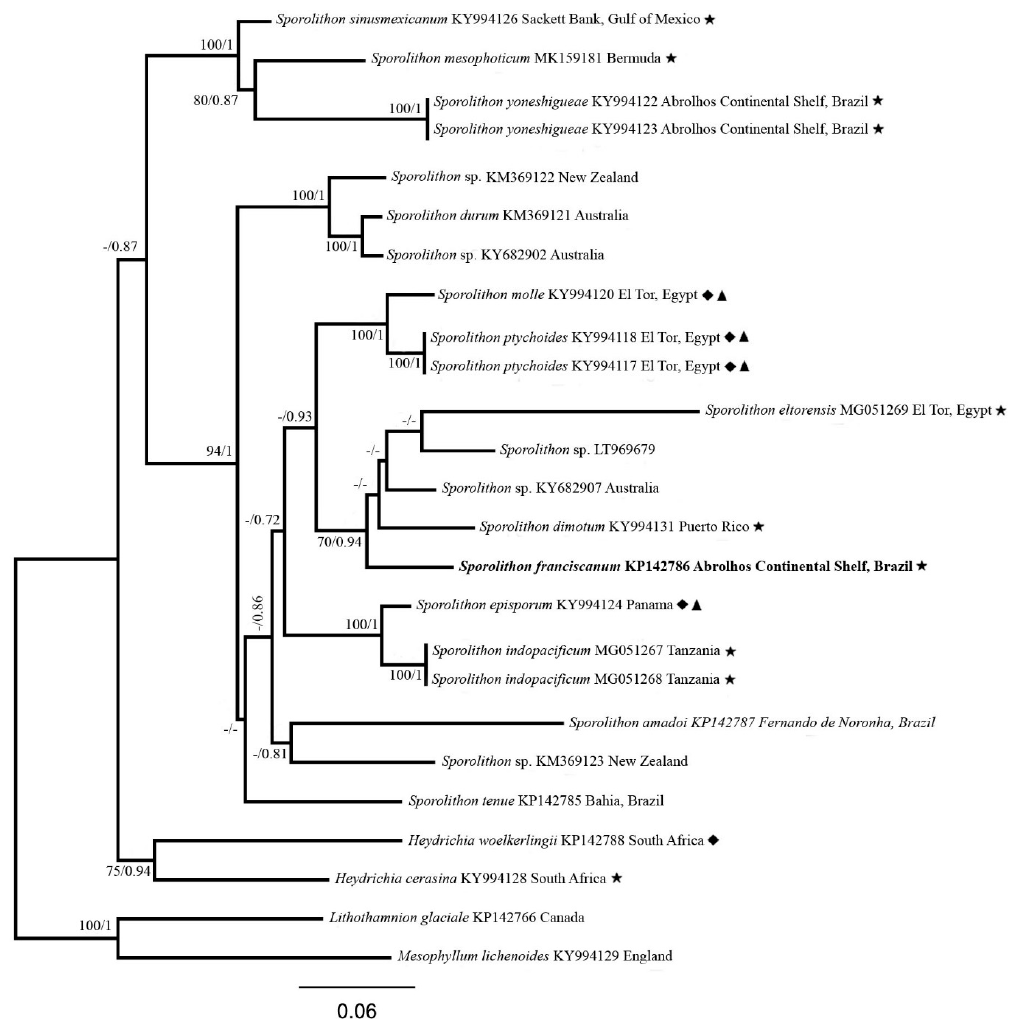
Figure 2. Phylogenetic tree inferred from RAxML and BI analyses of the rbcL dataset. Bootstrap support (1000 replicates) and Bayesian posterior probabilities (PP) are indicated at nodes. Bootstrap values lower than 70% and PP lower than 0.70 are not shown. Lithothamnion glaciale and Mesophyllum lichenoides were used as outgroups. Sporolithon franciscanum sp. nov. is marked in boldface type. Stars represent holotype, isotype, neotype, or paratype specimens; diamonds represent topotype specimens (specimens from the type locality); triangles represent species whose identification was confirmed by